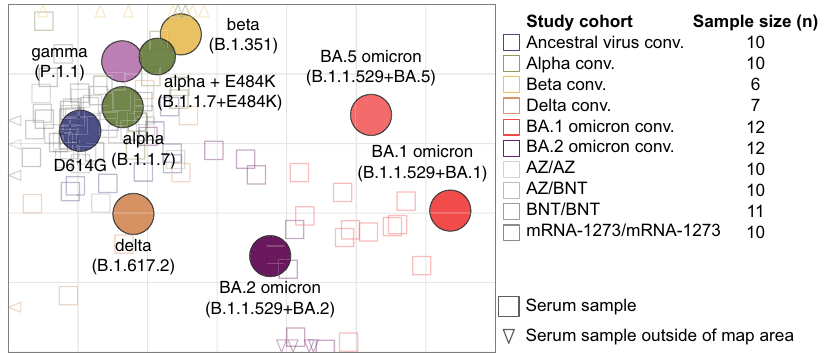
freeasonlyrelative distancescanbe inferred.Anon-zoomed inversionof themap is shown in Figure S2. Only single-variant exposure sera have been used for con- struction of the map. n =2 beta convalescent and n =6 BA.1 convalescent samples could not be positioned in the map because of too many <LOD titers. The table in the right part indicates how many sera from each group were positioned on the map (Ancestral virus conv. n =10, Alpha conv. n =10, Beta conv. n =6, Delta conv. n =7, BA.1 omicron conv. n =12, BA.2 omicron conv. n =12). Each of these serum samples has been titrated against D614G, alpha, alpha E484K, beta, gamma, delta, BA.1 omicron, BA.2 omicron, and BA.5 omicron variants. Neutralizing antibody titers are shown in Fig. 1 or have been published previously in 1,2